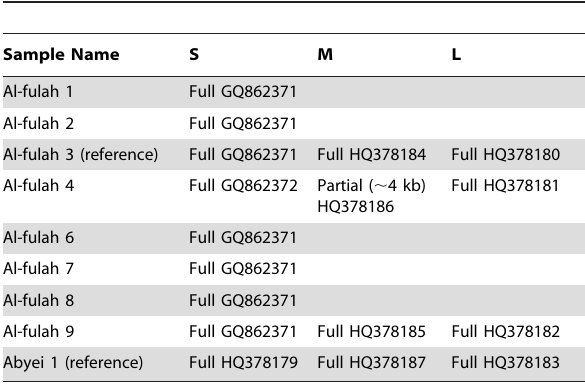
Table 2 . Genbank accession numbers for Sudanese CCHF